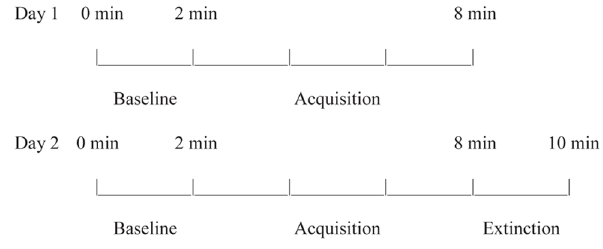
Figure 3. Infant mobile experimental protocol.